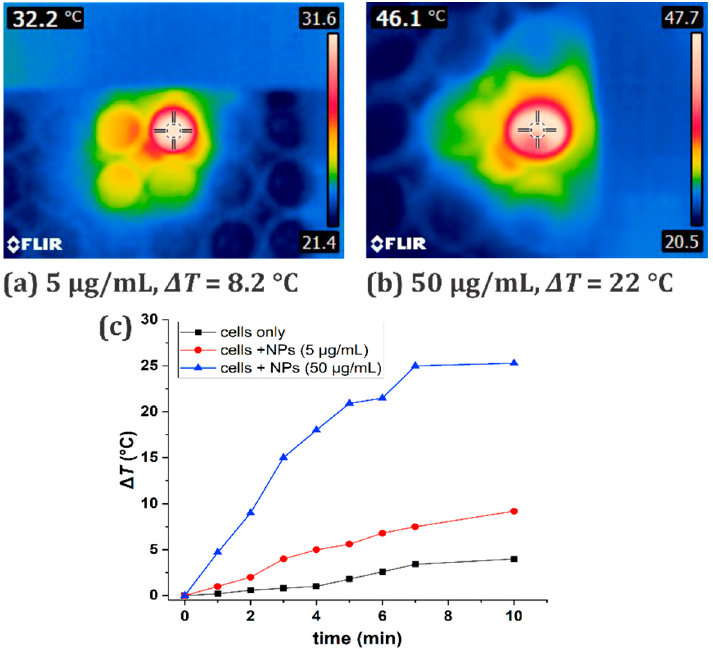
Figure 7. Thermal images of cells in a 24-well plate, irradiated with 808 nm laser for 10 min with P = 3 W/cm 2 , 24 h after incubation with nanoparticles (NPs) with concentration ( a ) 5 and ( b ) 50 μ g AuAg/mL. ( c ) Temperature profile recorded during 10-min irradiation.